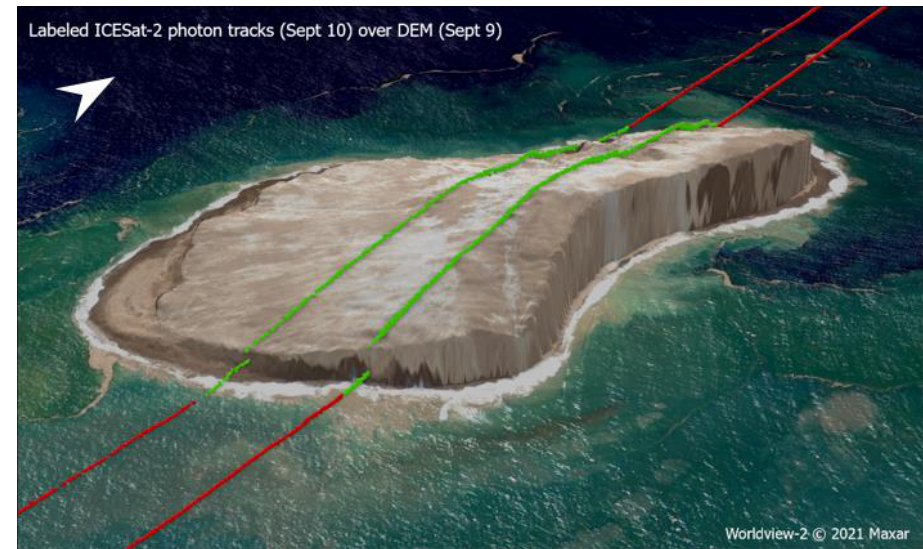
Figure 6. ICESat-2 tracks collected on 10 September 2021 overlain on a perspective view of 9 September 2021, Maxar Worldview-2 image draped over a DEM (generated from the WV02 stereo pair), displaying the geodetic topography measured via lidar altimetry. The DEM can be vertically controlled by means of the ICESat-2 to sub-meter levels, as shown here. ICESat-2 photons labeled as ground are in green and the sea surface in red.